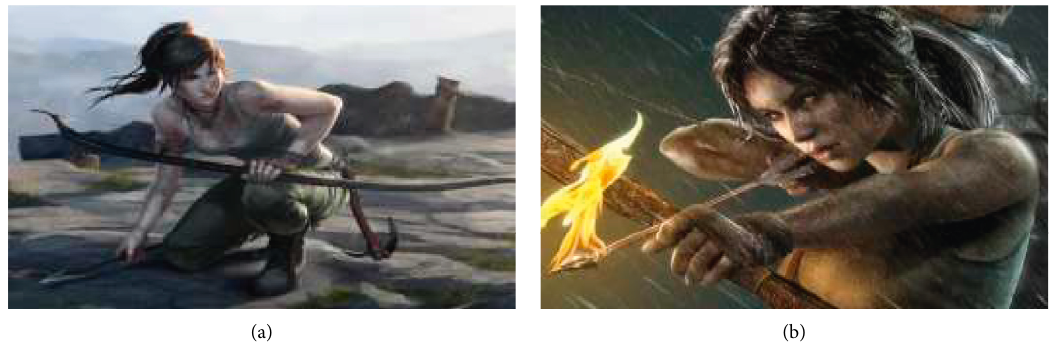
Figure 2: Characters in tomb raider. (a) Tomb raider 1. (b) Tomb raider 2.